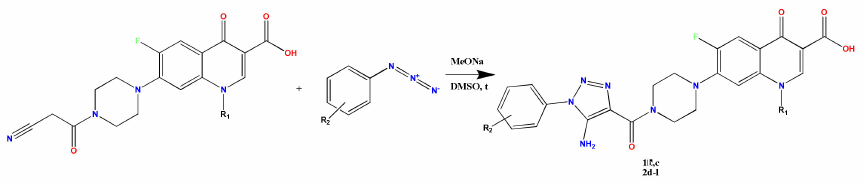
Figure 3. Synthesis of the target